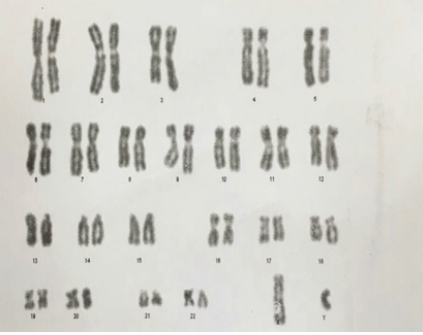
Figure 4: Bone marrow smear at spontaneous remission (4 weeks after sepsis resolution) showed 50–60% cellularity including suffi- cient megakaryocytes, the normal ratio of myeloid to elytroid cells, and no